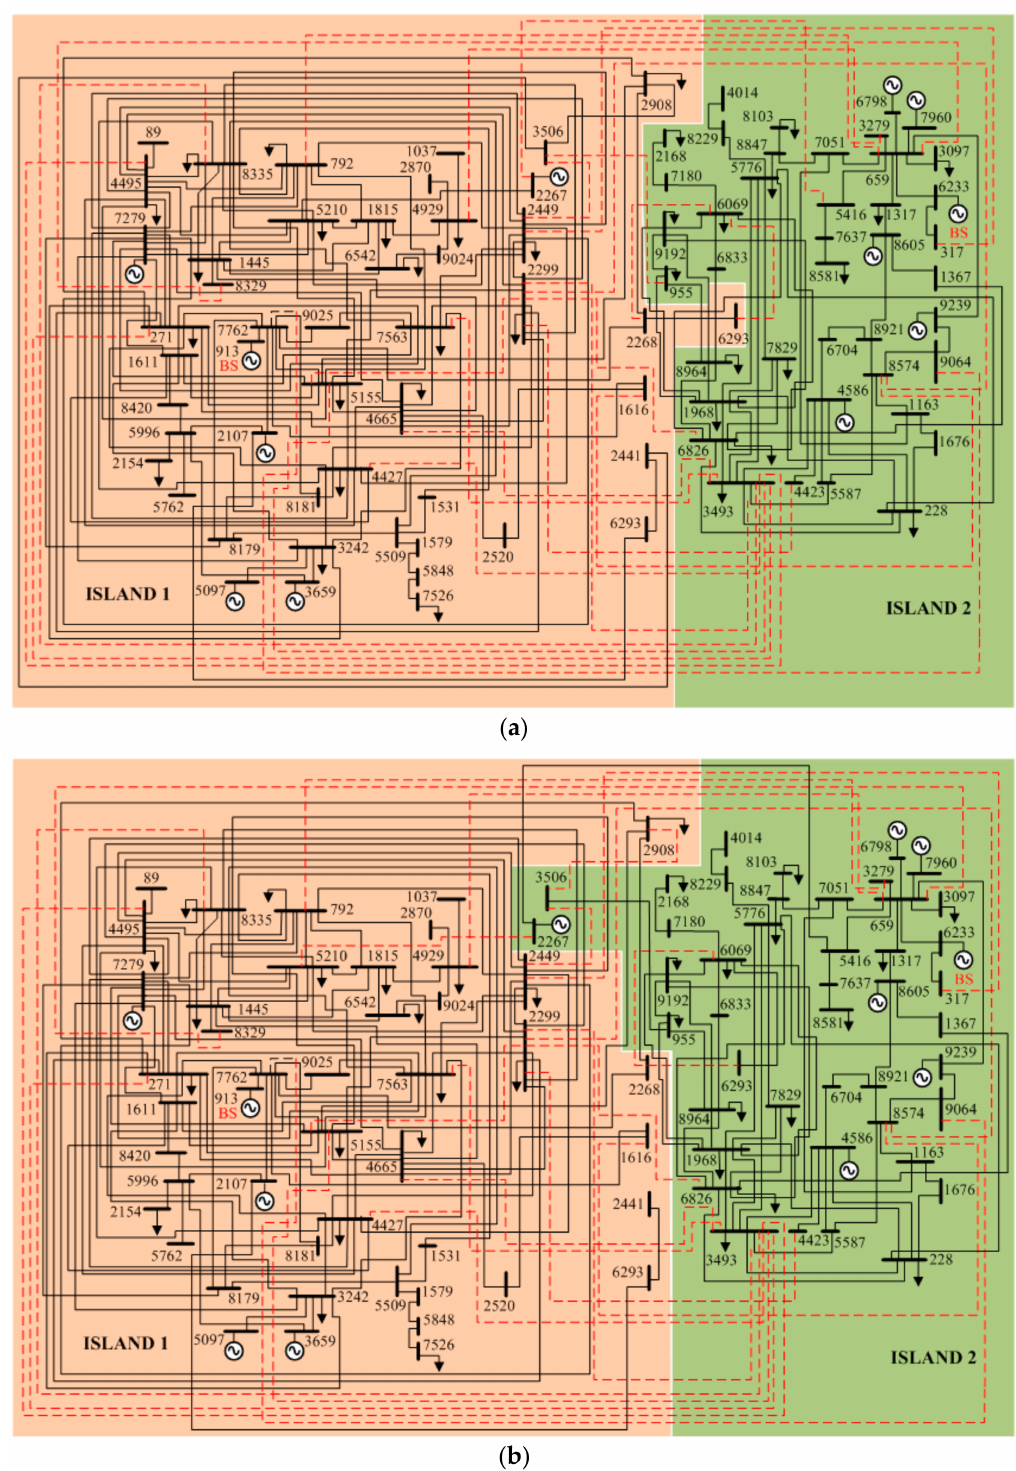
Figure 9. All islands’ unit restoration for the 89 bus European system, ( a ) Heuristic result ( b ) DABC